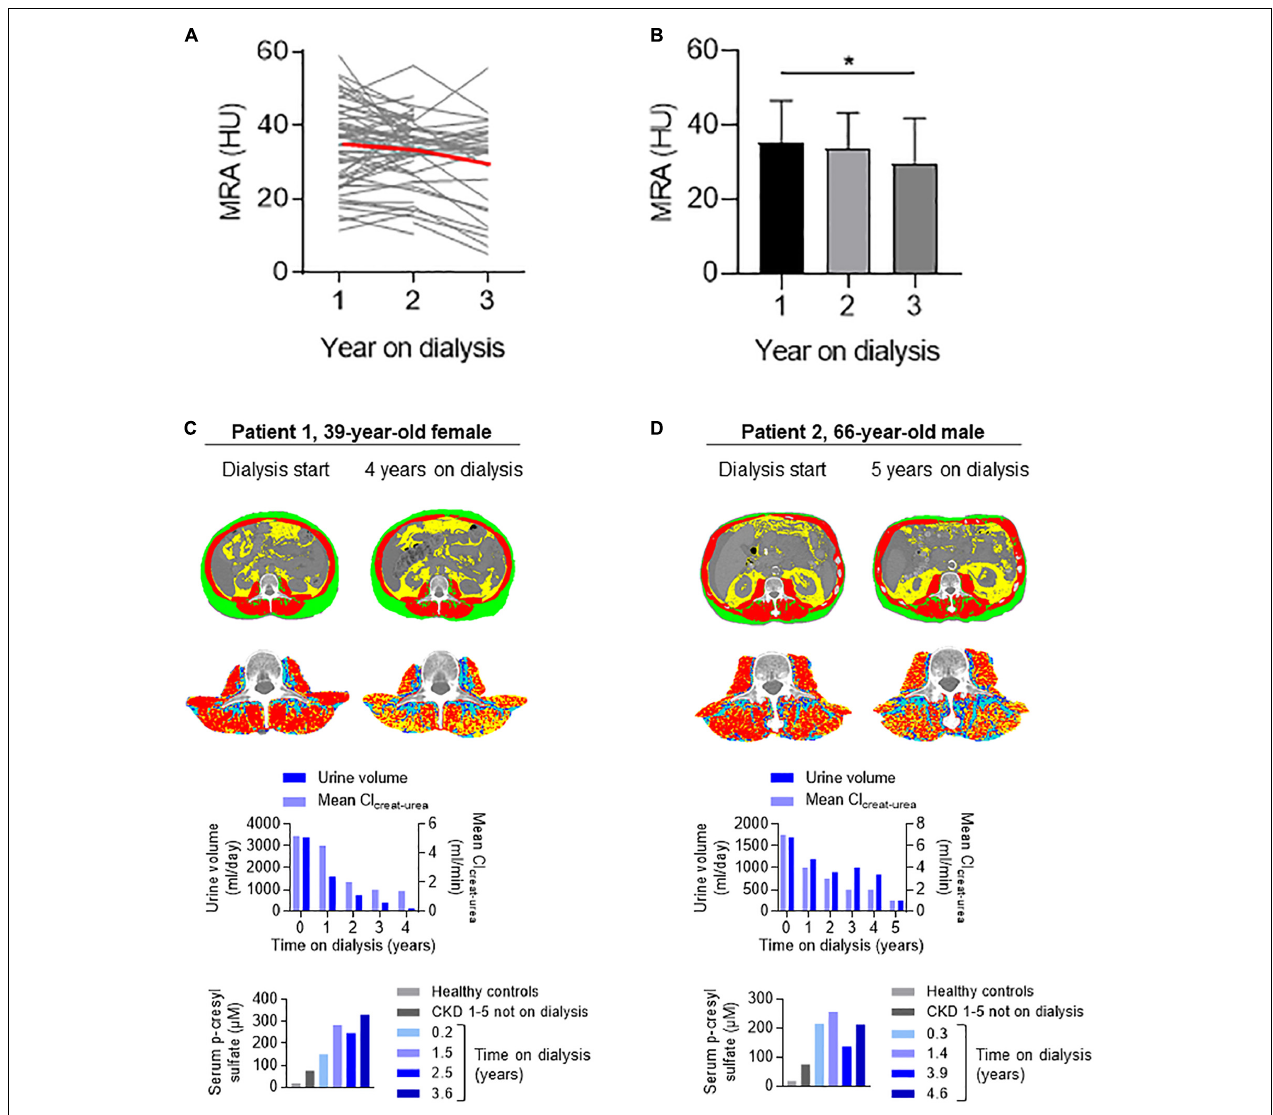
FIGURE 2 | Longitudinal changes in muscle radiation attenuation during time on dialysis. (A) Individual changes (gray thin lines) and mean values (red thick line) of MRA during time on dialysis. (B) Mean ( ± SD) values of MRA during the first, second, and third years on dialysis (* P = 0.03 for linear trend, one-way ANOVA). (C,D) Illustrative longitudinal data of fat distribution, residual kidney function, and serum p-cresyl sulfate levels from two individuals on long-term PD: a 39-year-old woman on PD for 4 years (patient 1) and a 66-year-old man on PD for 5 years (patient 2). In both patients, a significant decrease in mean MRA (from 37.0 to 24.0 HU in patient 1 and from 37.6 to 27.2 HU in patient 2) paralleled the loss in residual function and accumulation of circulating p-cresyl